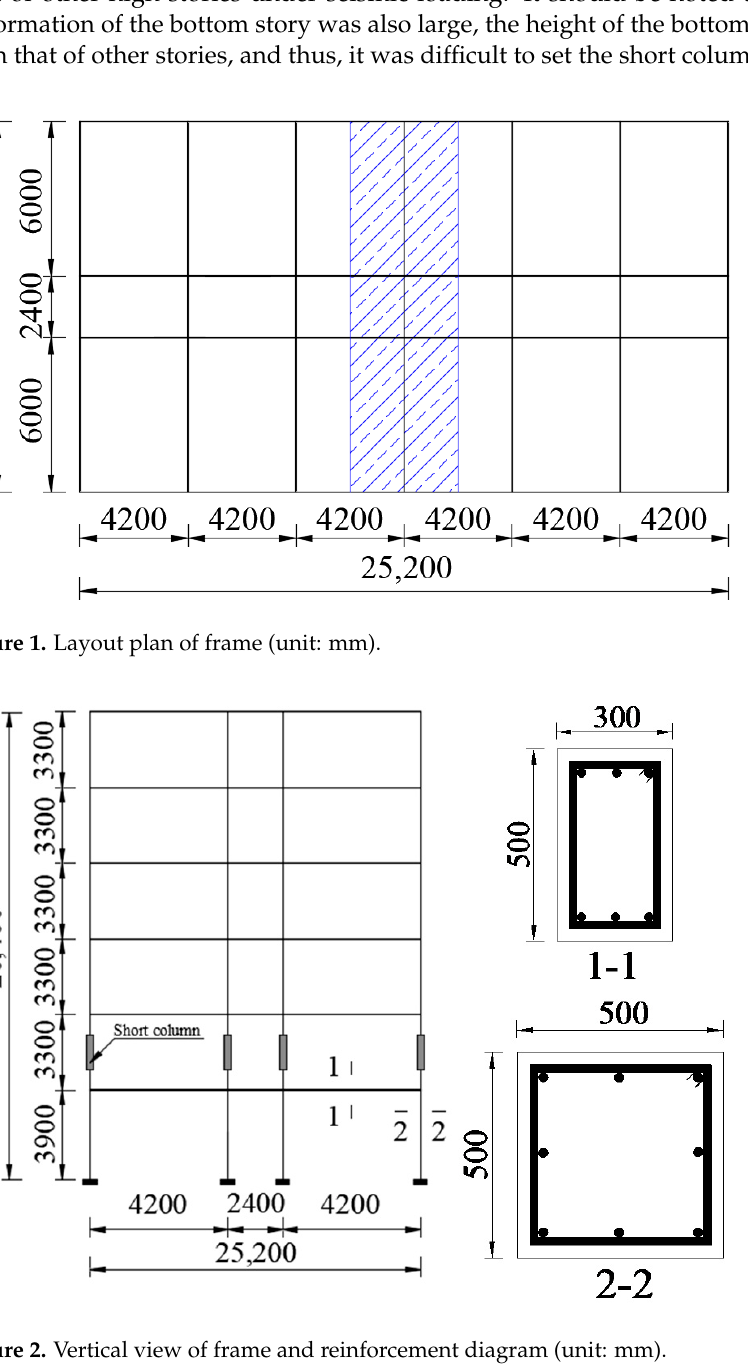
Figure 2. Vertical view of frame and reinforcement diagram (unit: mm).